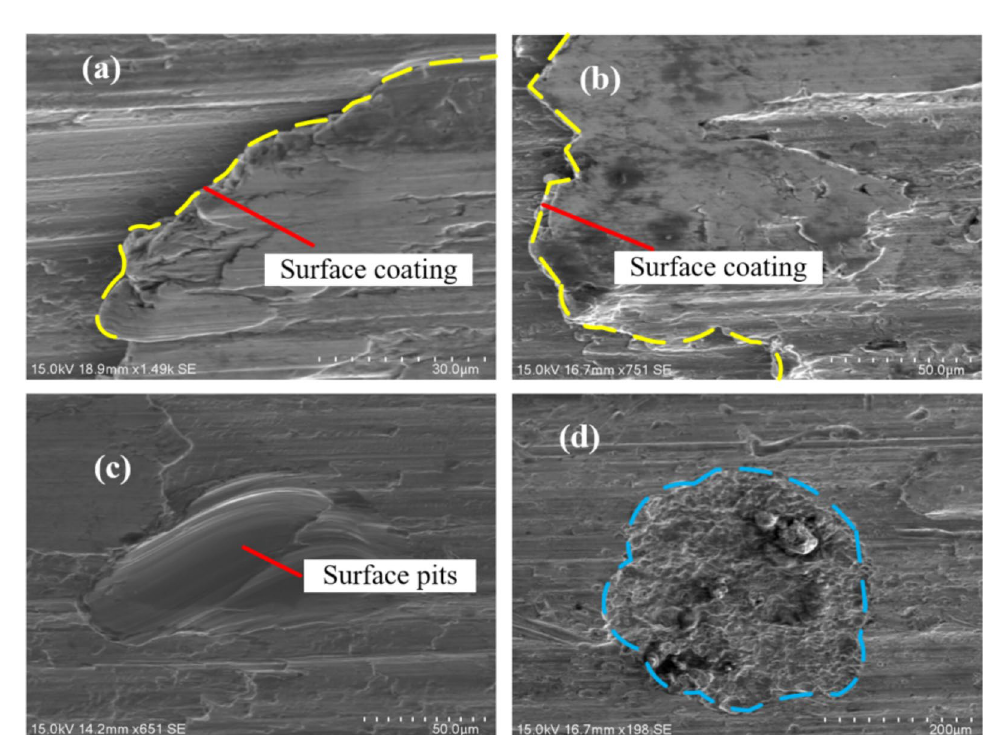
Figure 16 Surface coating and pits of contour bevel gear machined by dry